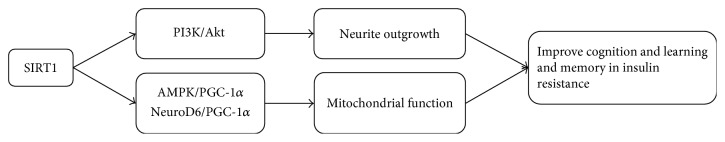
The role of SIRT1 in cognition and learning and memory under the condition of IR. SIRT1 has been shown to increase neurite outgrowth by activating the PI3K/Akt pathway and improve mitochondrial function through the AMPK/PGC-1α and NeuroD6/PGC-1α pathways. PI3K: phosphoinositide 3-kinase; AMPK: adenosine monophosphate-activated protein kinase; PGC-1α: PPARγ coactivator 1-α; NeuroD6: neuronal differentiation 6.